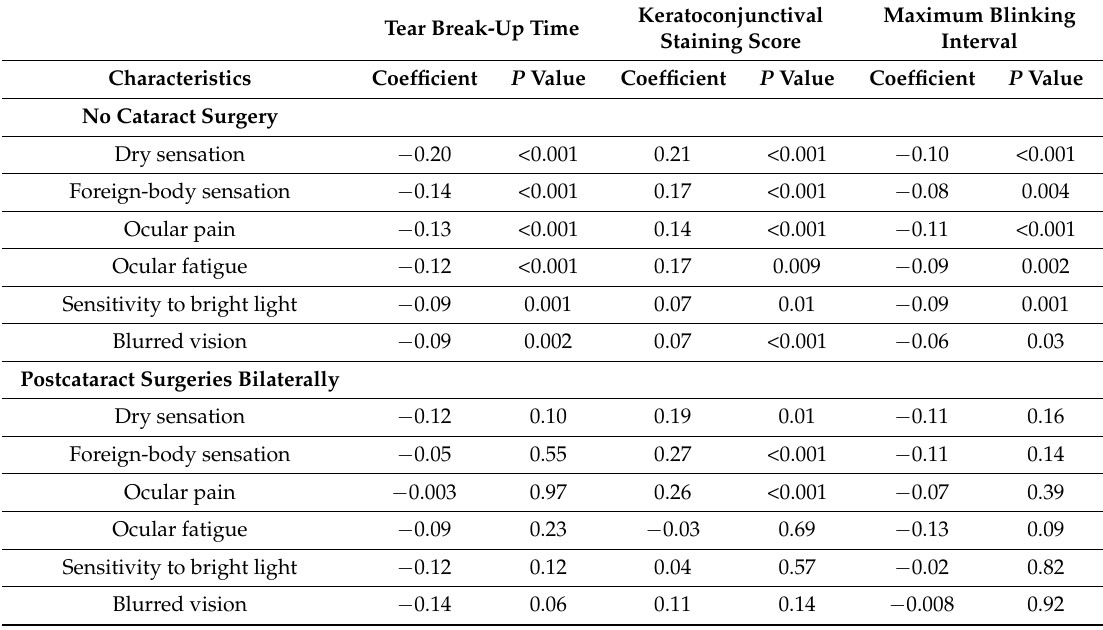
Table 3. Association between dry eye subjective symptoms and objective signs according to bilateral cataract surgical histories *. Tear Break-Up